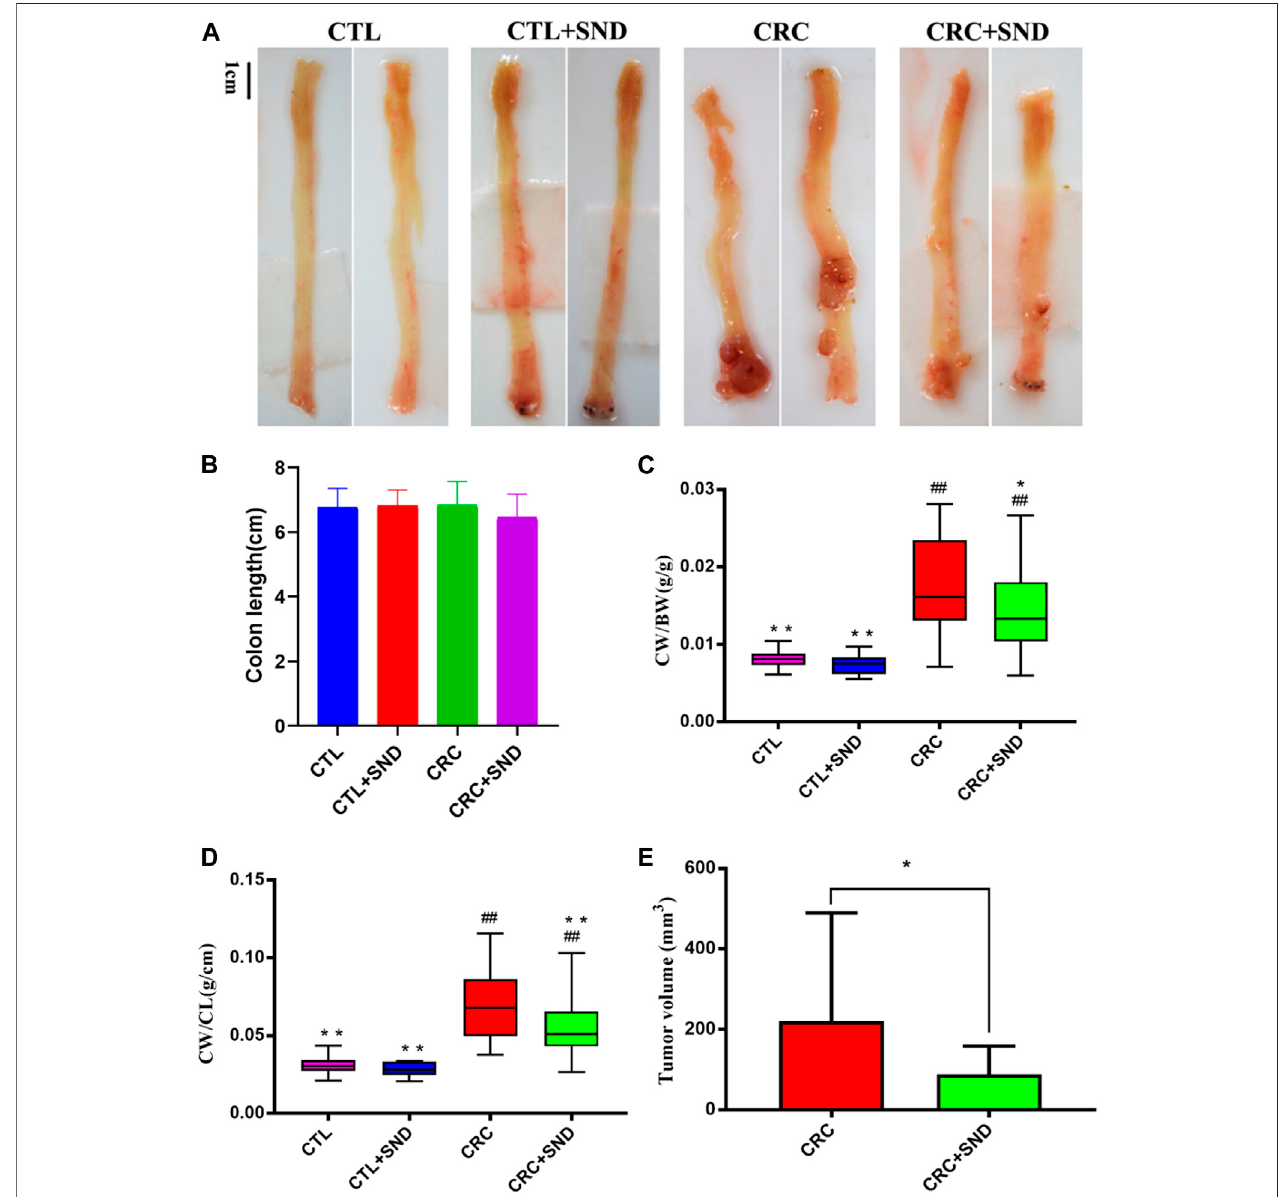
FIGURE 2 | The effect of SND on colonic phenotype. (A) Colonic phenotype of different groups, n (cid:2) 5. (B) Colon length of different groups, n (cid:2) 5. (C,D) Colon weight(CW)/Bodyweight(BW)andcolonweight (CW)/Body weight (BW)arechosentobeindicatorsofcolonweight, n (cid:2) 5. (E) Tumorvolumeofdifferentgroups, n (cid:2) 5. Compared to CRC group, * p < 0.05, ** p < 0.01; compared to CTL group, ## p < 0.01.